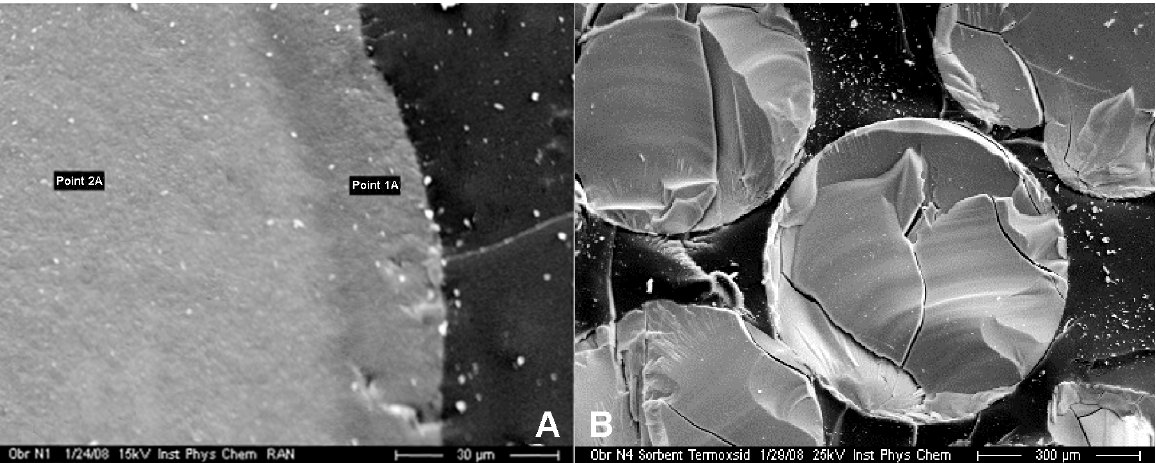
Figure 4. Scanning electron micrograph/image of FNS ( A ) and Termoksid-35 ( B ) sorbent granules’ cross-sections (SEM analysis data).